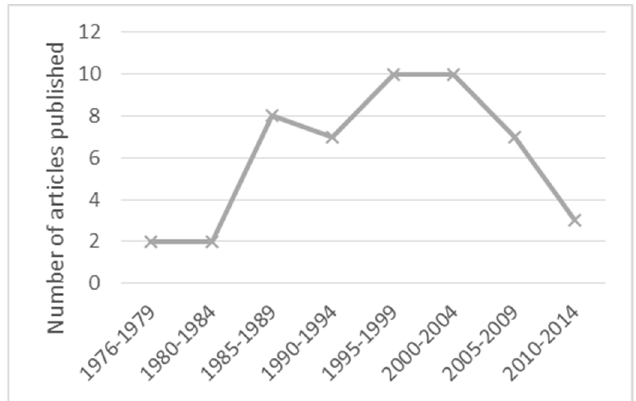
Figure 1. Outbreaks and infections associated with construction, renovation, or demolition described in published articles from 1976 to 2014. Author’s adaptation of [23].